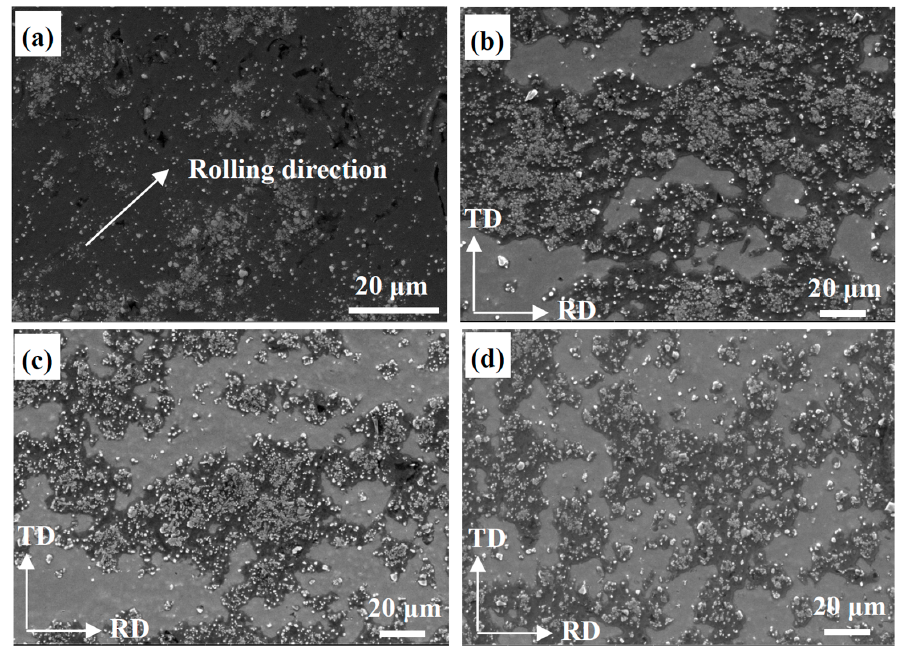
Figure 3. Microstructures ofAl-TiB 2 /TiC in situ composites with different deformation processes (in RD-TD plane). ( a ) Rolling for 90% reduction; ( b – d ) Following one, two and four ARB cycles, respectively.